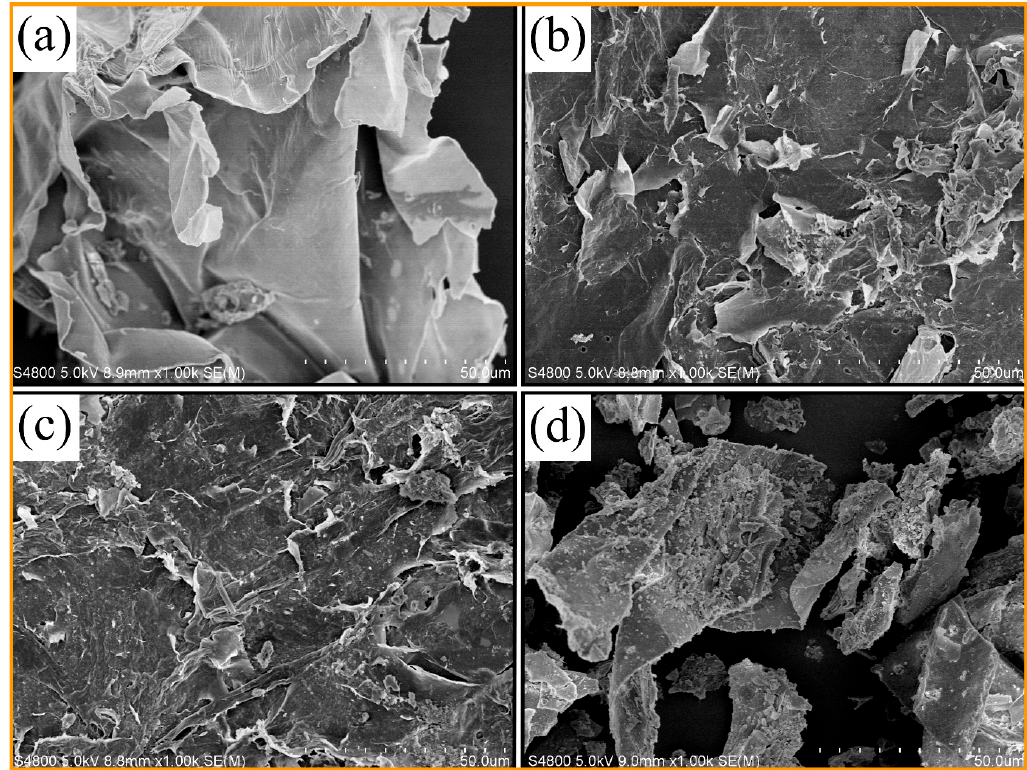
Figure 5. SEM images of CS ( a ), LR-130 ( b ), LR-150 ( c ) and LR-170 ( d ).